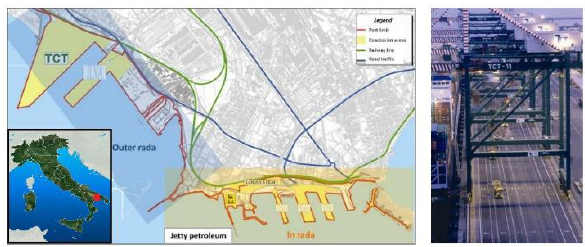
Figure 1. The Port of Taranto: plan of the area (left) and panoramic image of TCT